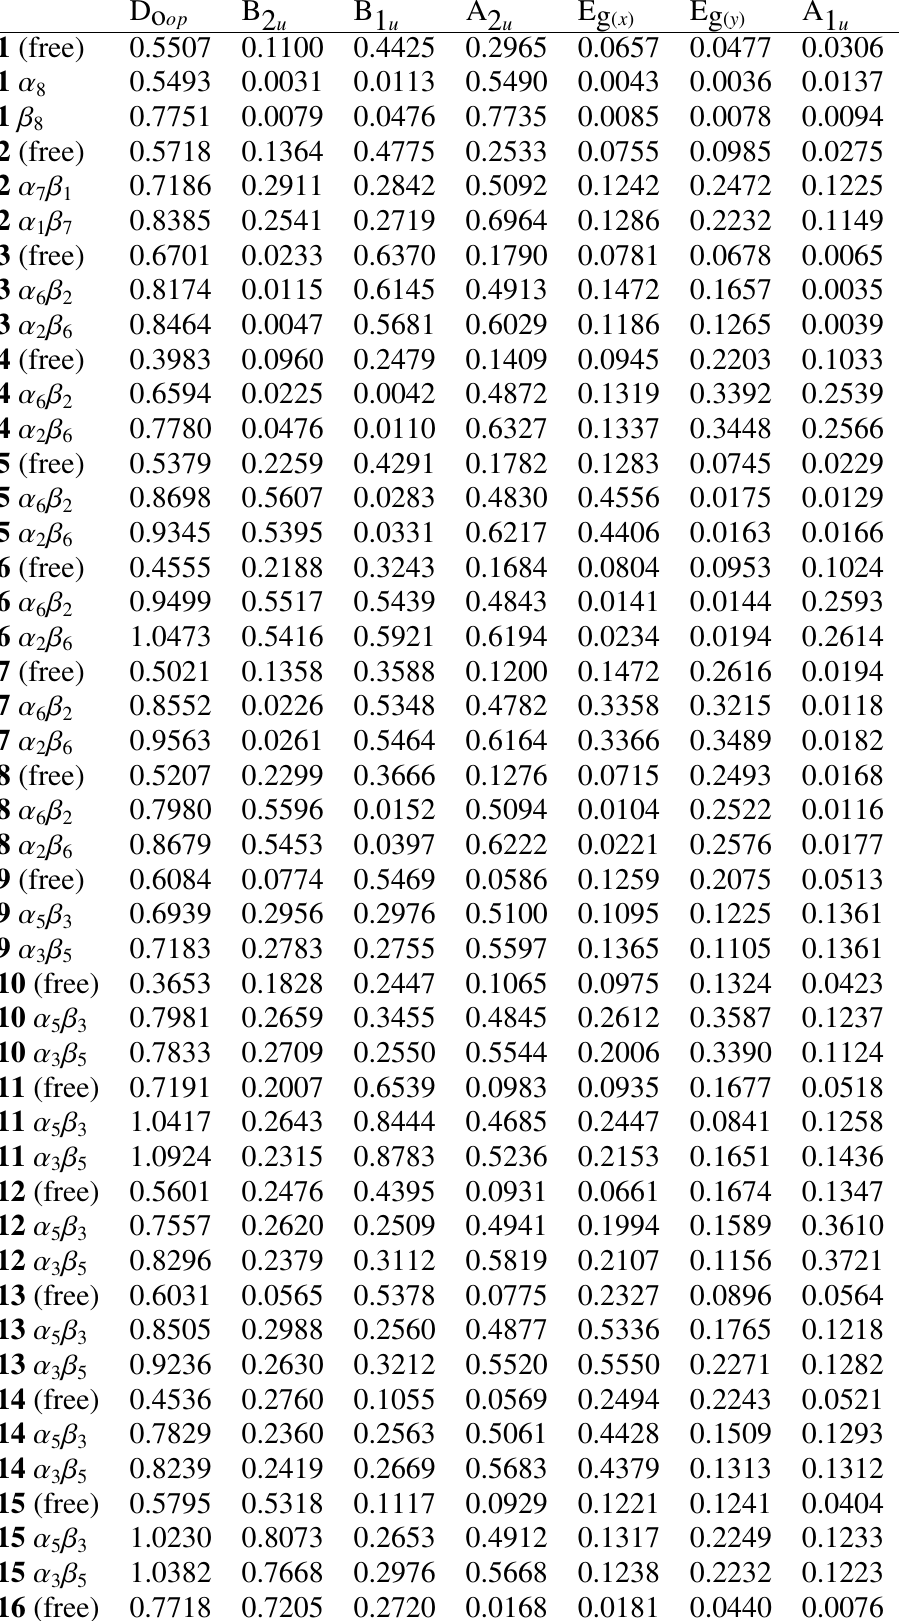
Appendix Table 2A : Complete NSD results for 28 minimum energy conformers of Ni(OEP) (free), and for 43 final optimized conformations of Ni(OEP) adsorbed on graphite(0001) layer. The contribu- tions to the porphyrin core distortions along the lowest-frequency normal coordinates are